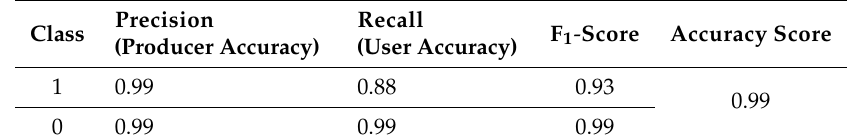
Table 1. Validation of results of our model using the set of weights with the lowest test error. Class 0 represents the background, and Class 1 corresponds to center pivot irrigation systems.